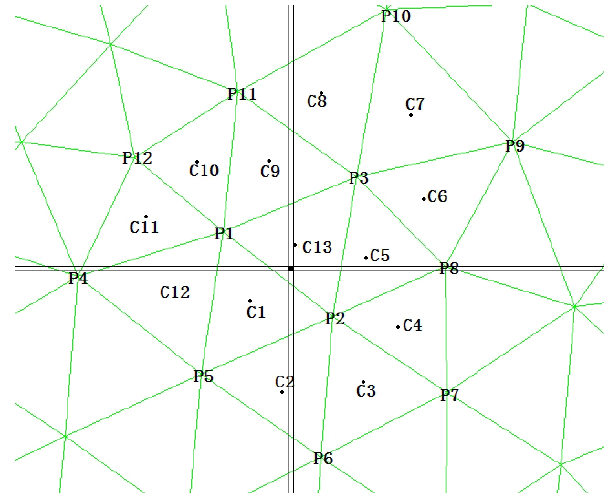
Figure 5. The scheme of spatial interpolation.